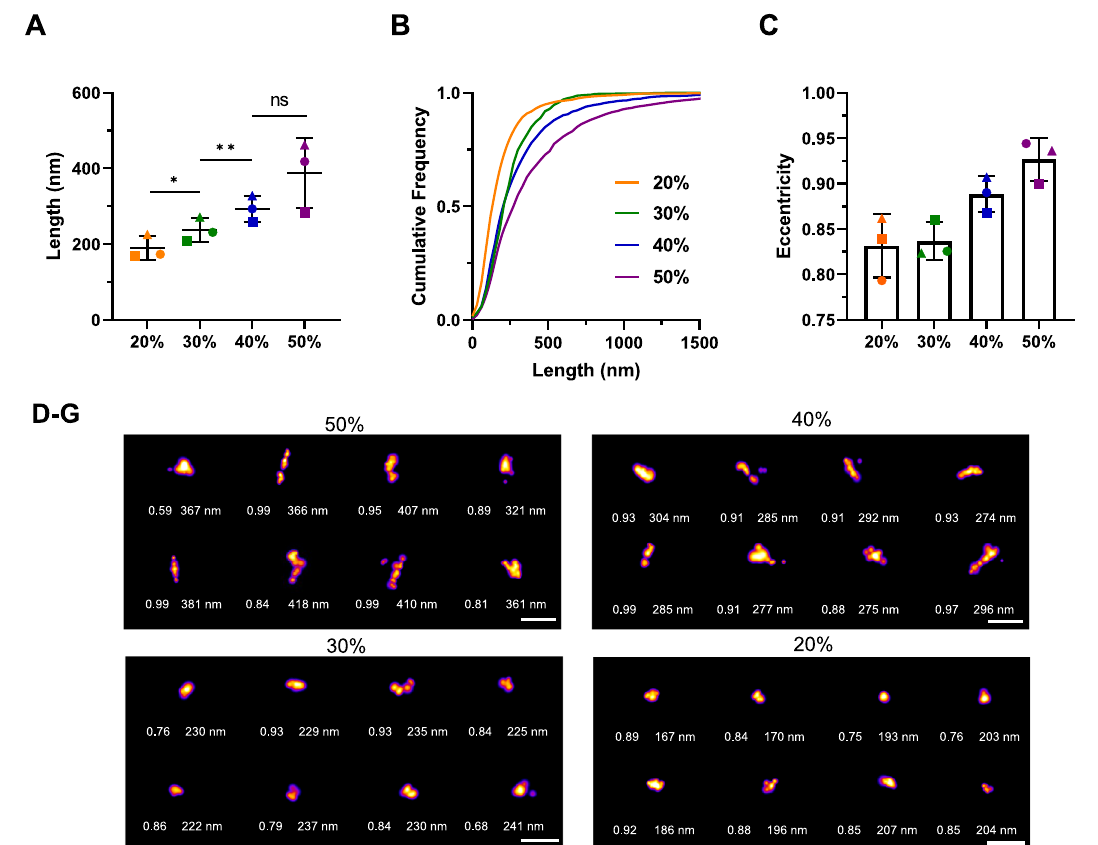
Fig.3|Lengthdistributionofthesucrosefractionsfromsingle-moleculesuper- resolution microscopy using thio fl avin X. A Scatter plot with each point repre- senting one of three biological replicates. Error bars are mean±STD. Statistical testing using two-tailed paired t -test from N =3, p =0.0144 for 20% vs 30%, p =0.0496 for 30% vs 40%, p =0.2939 for 40% vs 50%. B Cumulative frequency distributionof α -synucleinaggregatesinthecorrespondentsucrosefractions.One representative out of three independent replicates. C Mean eccentricity for each